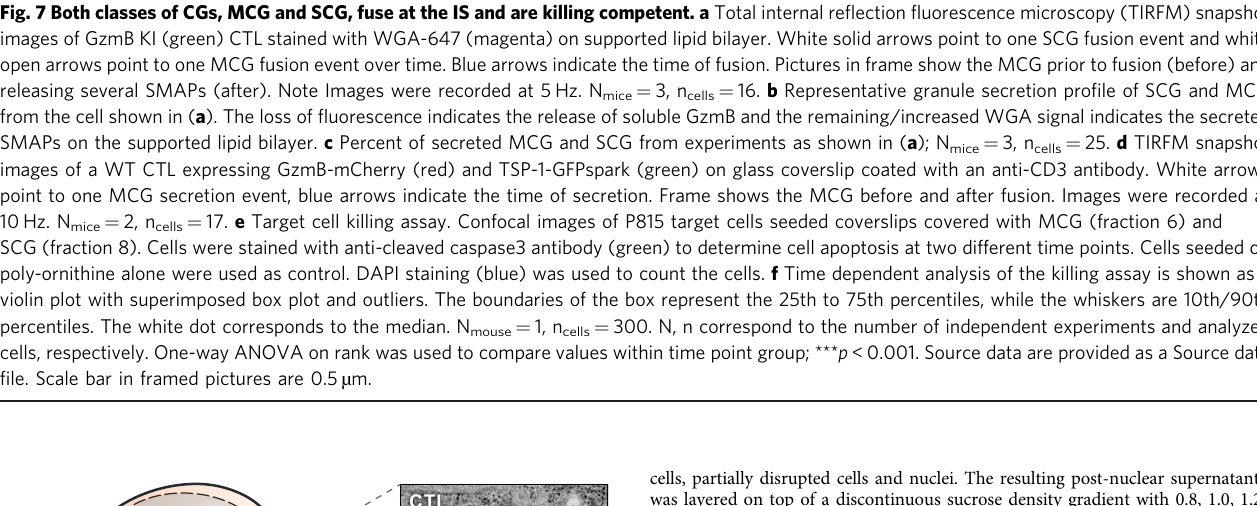
Fig. 7 Both classes of CGs, MCG and SCG, fuse at the IS and are killing competent. a Total internal re fl ection fl uorescence microscopy (TIRFM) snapshot images of GzmB KI (green) CTL stained with WGA-647 (magenta) on supported lipid bilayer. White solid arrows point to one SCG fusion event and white open arrows point to one MCG fusion event over time. Blue arrows indicate the time of fusion. Pictures in frame show the MCG prior to fusion (before) and releasing several SMAPs (after). Note Images were recorded at 5 Hz. N mice = 3, n cells = 16. b Representative granule secretion pro fi le of SCG and MCG from the cell shown in ( a ). The loss of fl uorescence indicates the release of soluble GzmB and the remaining/increased WGA signal indicates the secreted SMAPs on the supported lipid bilayer. c Percent of secreted MCG and SCG from experiments as shown in ( a ); N mice = 3, n cells = 25. d TIRFM snapshot images of a WT CTL expressing GzmB-mCherry (red) and TSP-1-GFPspark (green) on glass coverslip coated with an anti-CD3 antibody. White arrows point to one MCG secretion event, blue arrows indicate the time of secretion. Frame shows the MCG before and after fusion. Images were recorded at 10 Hz. N mice = 2, n cells = 17. e Target cell killing assay. Confocal images of P815 target cells seeded coverslips covered with MCG (fraction 6) and SCG (fraction 8). Cells were stained with anti-cleaved caspase3 antibody (green) to determine cell apoptosis at two different time points. Cells seeded on poly-ornithine alone were used as control. DAPI staining (blue) was used to count the cells. f Time dependent analysis of the killing assay is shown as a violin plot with superimposed box plot and outliers. The boundaries of the box represent the 25th to 75th percentiles, while the whiskers are 10th/90th percentiles. The white dot corresponds to the median. N mouse = 1, n cells = 300. N, n correspond to the number of independent experiments and analyzed cells, respectively. One-way ANOVA on rank was used to compare values within time point group; *** p < 0.001. Source data are provided as a Source data fi le. Scale bar in framed pictures are 0.5 µ m.